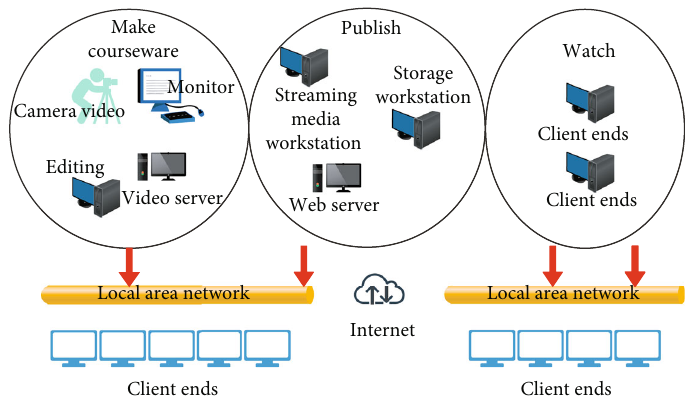
Figure 1: Topological structure of the system.